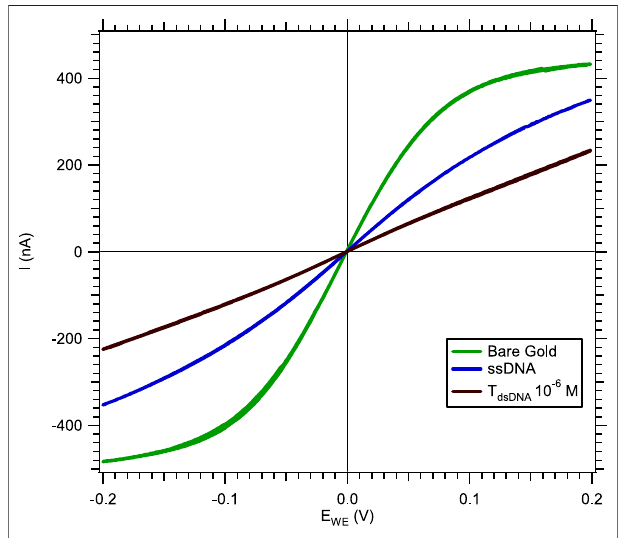
FIGURE 2 | Cyclic voltammetry response of a microband WE in a solution of 3 mM [Fe (III) (CN) 6 ] 3 − /[Fe (II) (CN) 6 ] 4 − and 0.5 M NaCl, with a 10 mV.s − 1 scan rate and a 0.5 μ L.s − 1 fl ow rate, showing the current absolute value decreasing after